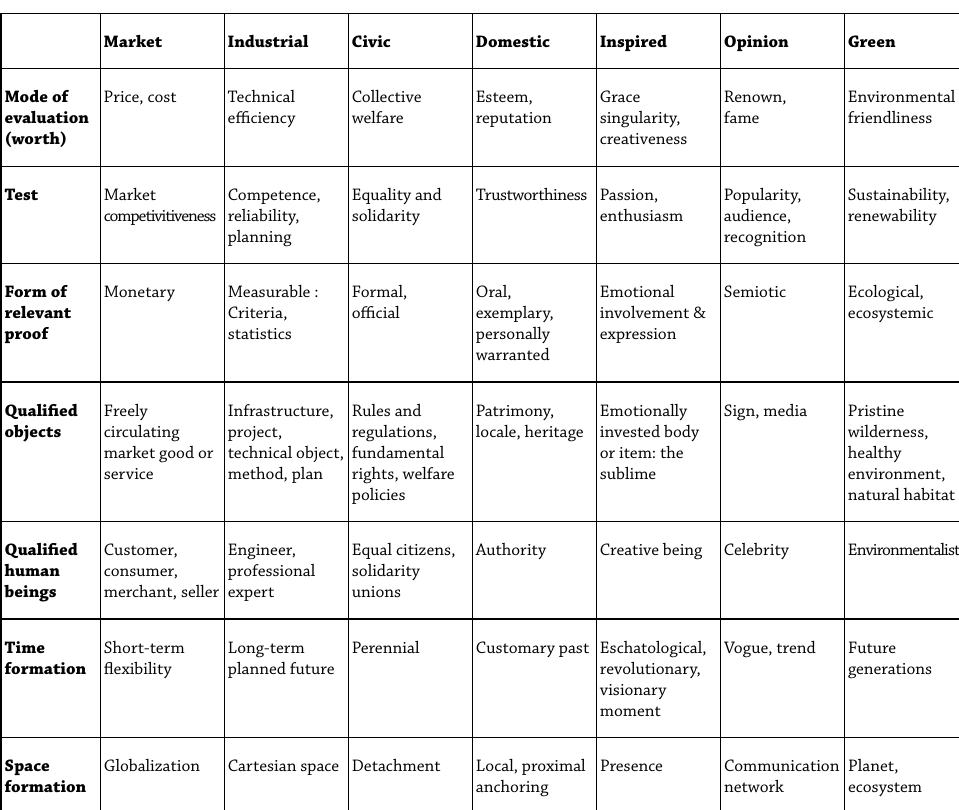
Table 1: The seven orders of worth Civic Domestic Inspired Opinion